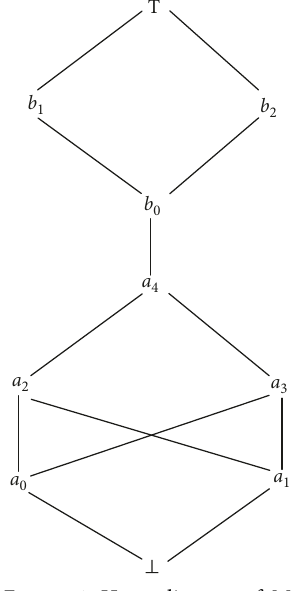
Figure 1: Hasse diagram of M